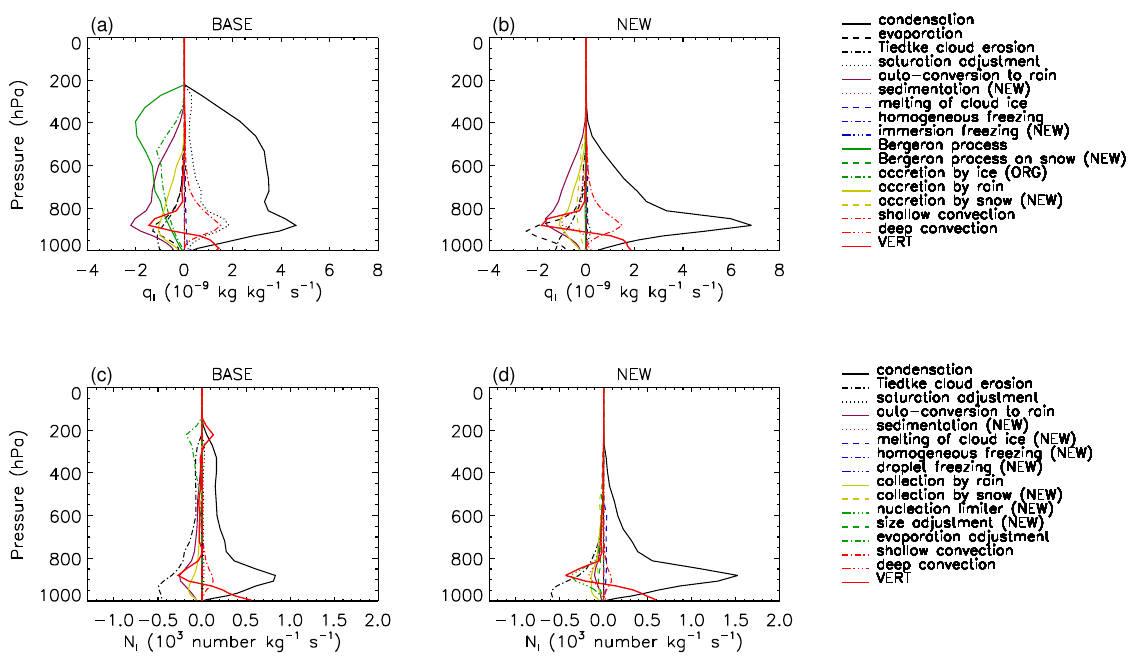
Fig. 10. Global budgets of cloud (droplet) liquid water amount ( a and b ), liquid droplet number ( c and d ). Legends are provided for each row. If a term is only calculated in one of the runs, the name of the run is indicated in brackets. VERT stands for vertical advection and turbulence.